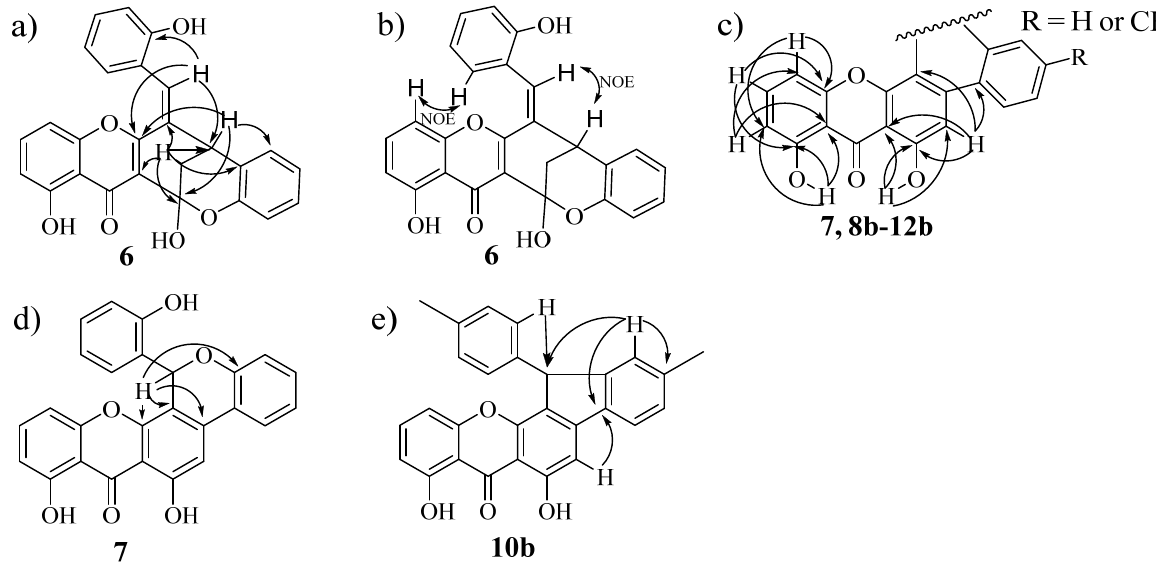
Figure 2. Main HMBC and NOESY